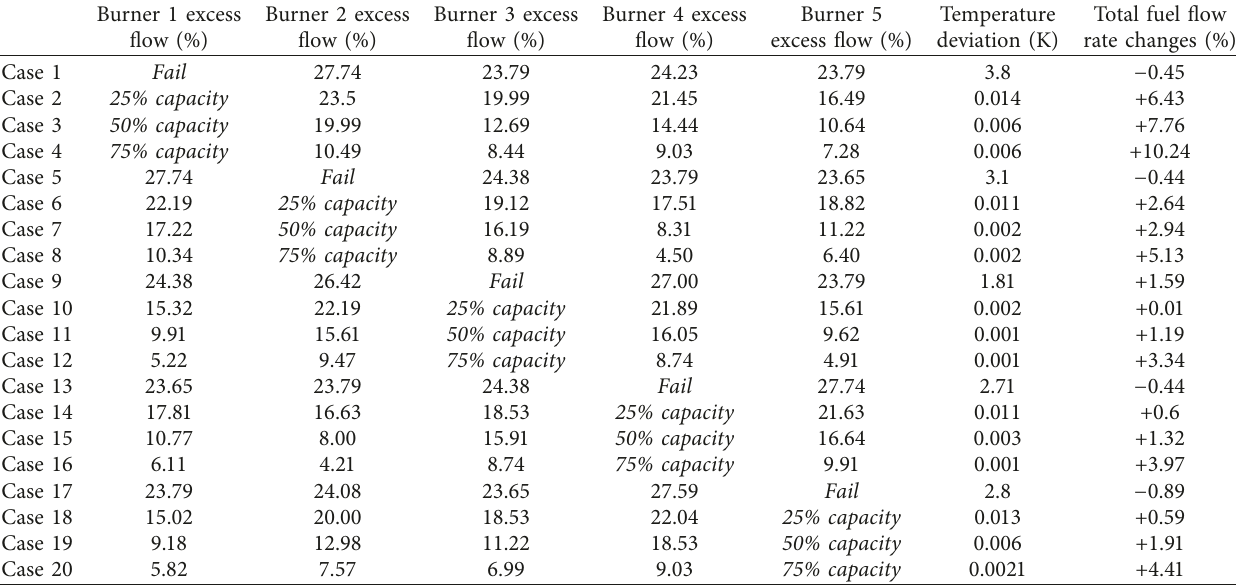
Table 3: Single-burner failure/firing capacity shortage.